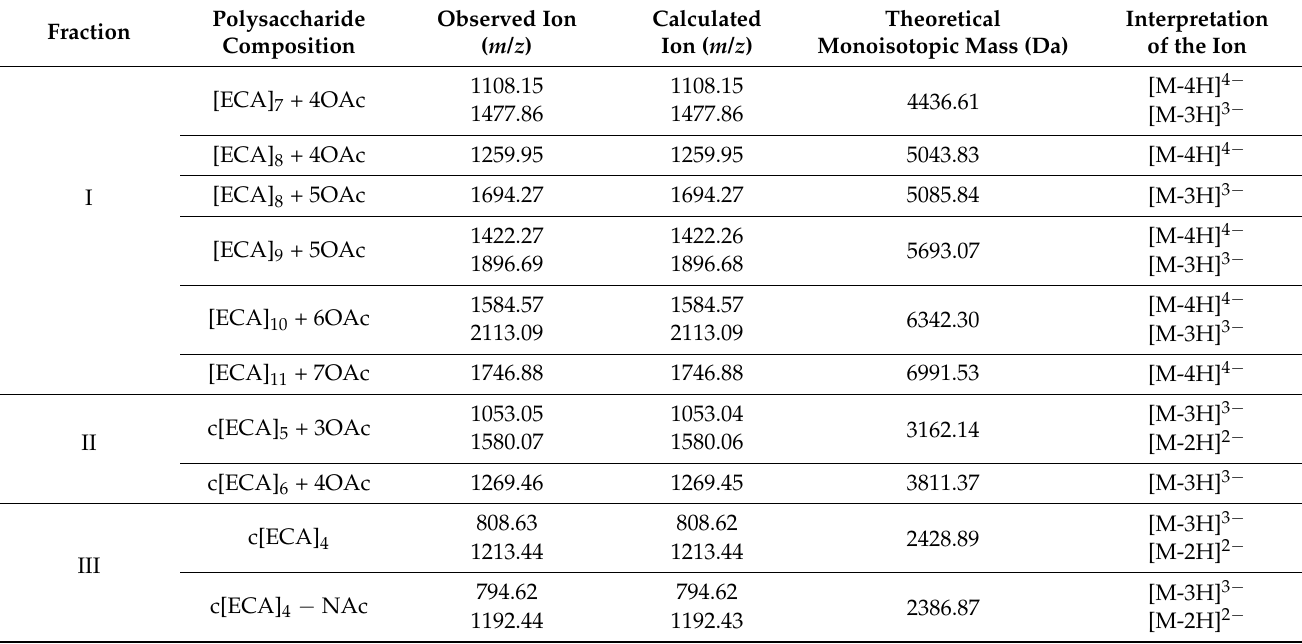
Table 1. Interpretation of main ions observed in fractions I–III from S. sonnei phase II supernatant (ESI-MS, negative ion mode, [M − nH] n −